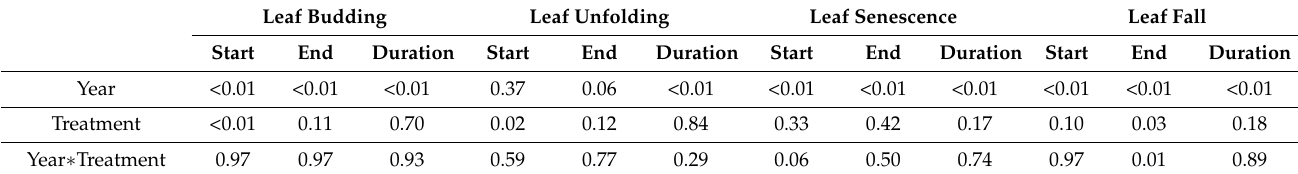
Figure 3. Change trend of soil water content (SWC) at 0–10 ( A , D ), 10–20 ( B , E ) and 20–30 cm ( C , F ) one day before ( − 1) and one day (+1), three days (+3) and seven days (+7) after the enhancement of precipitation compared with the control in 2012 and 2013. Table 1. The p values of a two-way ANOVA of the influence of precipitation enhancement treatment and its interaction on the phenology of Nitraria tangutorum